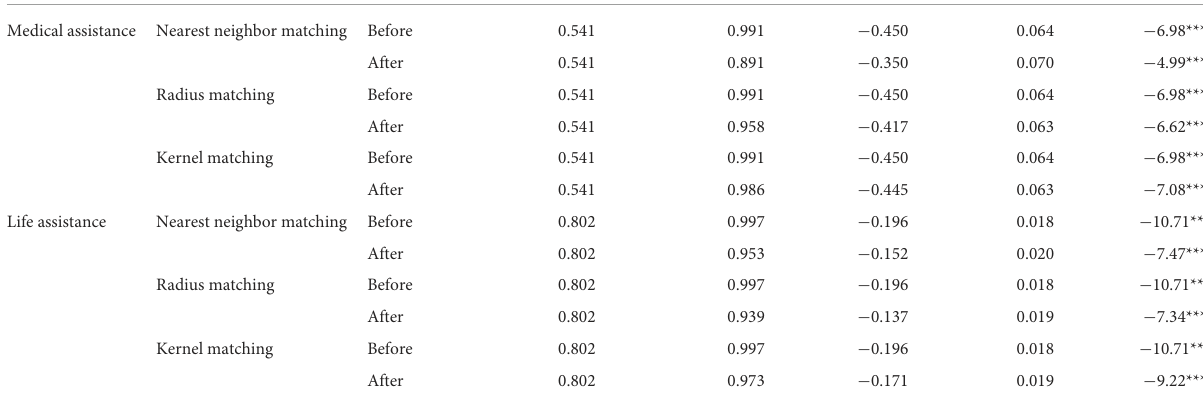
TABLE 5 Self-choice processing of residents with medical assistance and life assistance. Categorical Processing group Control group ATT value Standard deviatio T -value Medical assistance Nearest neighbor matching Before